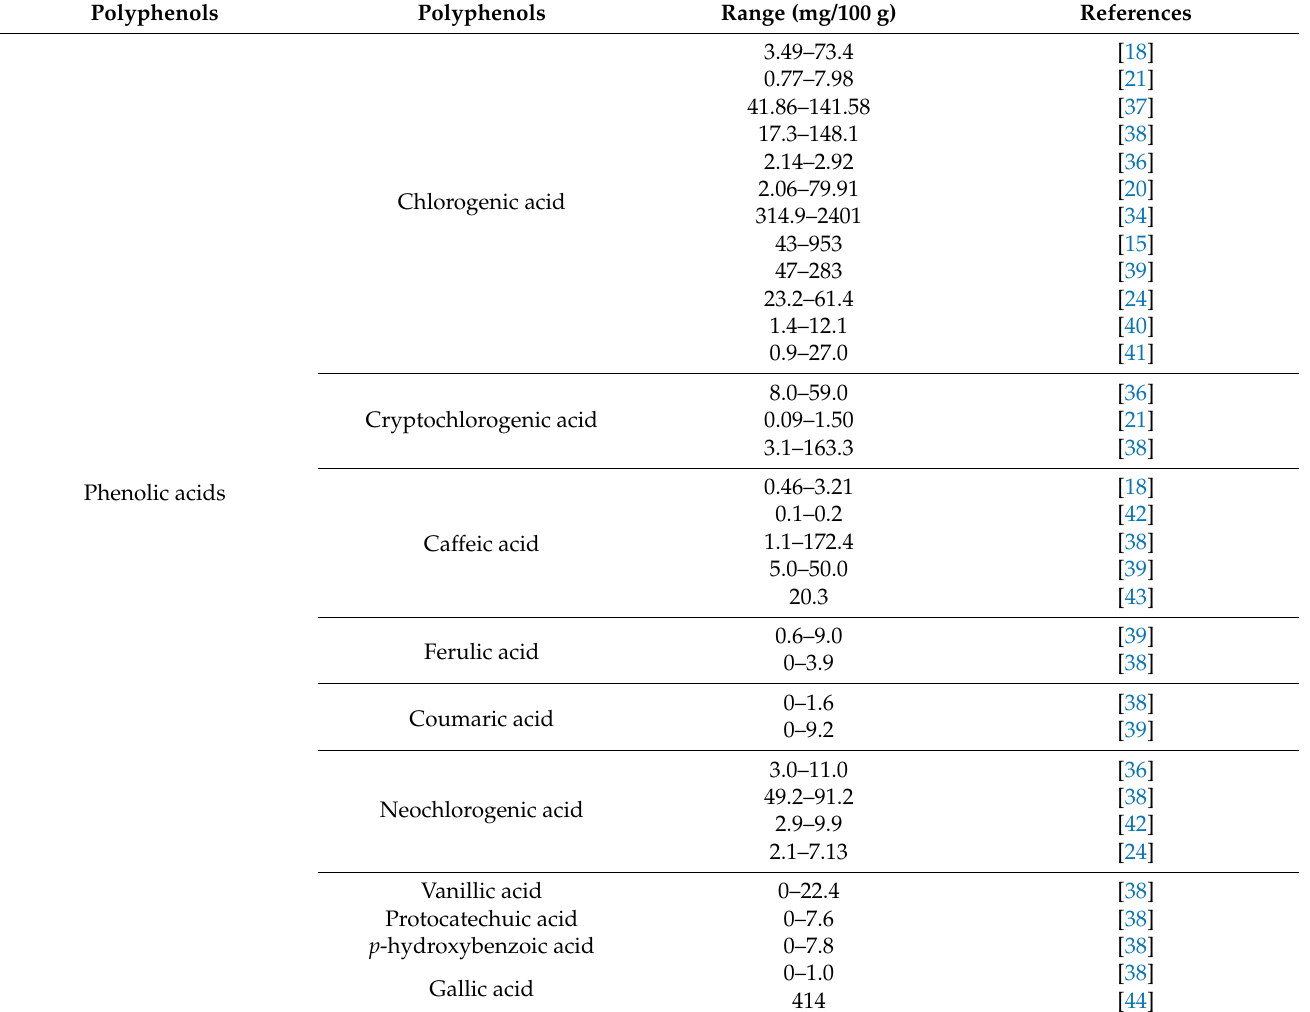
Table 1. Diverse range of polyphenols in